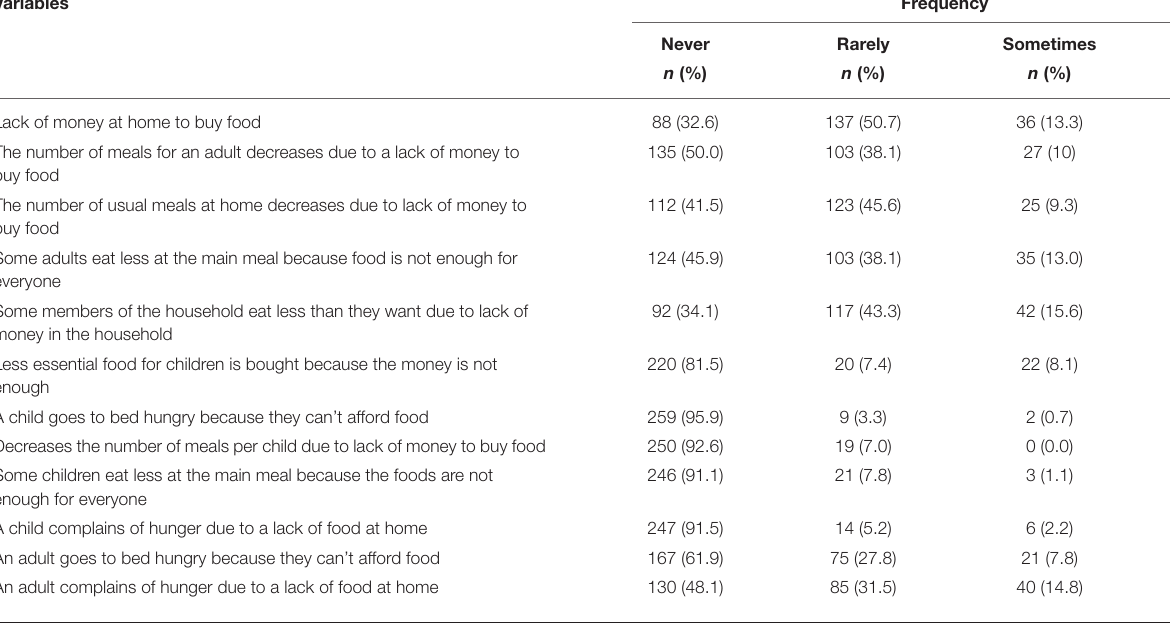
TABLE 2 | Frequency of occurrence on indicators of the Venezuelan Food Security Scale of student’s households in Caracas, 2016. Variables Frequency Never Rarely Sometimes